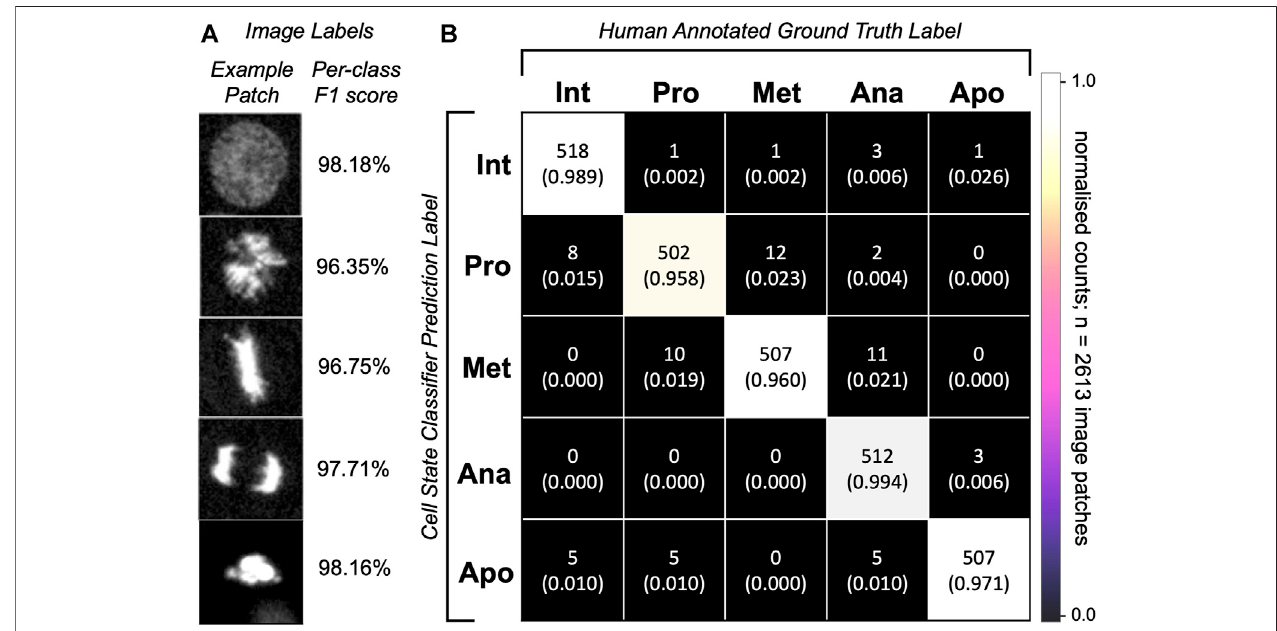
FIGURE 5 | Single-cell classi fi cation performance. (A) Representative predictions from the trained network for the given images patches. Depicted is an image patch ( fl uorescence channel only) centred at the cell nucleus representative of the class label with a per-class F1-score calculated on 2,613 single-cell images in the testing dataset. (B) Confusion matrix for cell state labelling of the testing patch dataset ( > 500 images per class) of cell image crops. Per-class image patch counts and their normalised counts are depicted. Comparison of human annotations vs. the classi fi er-generated annotations are